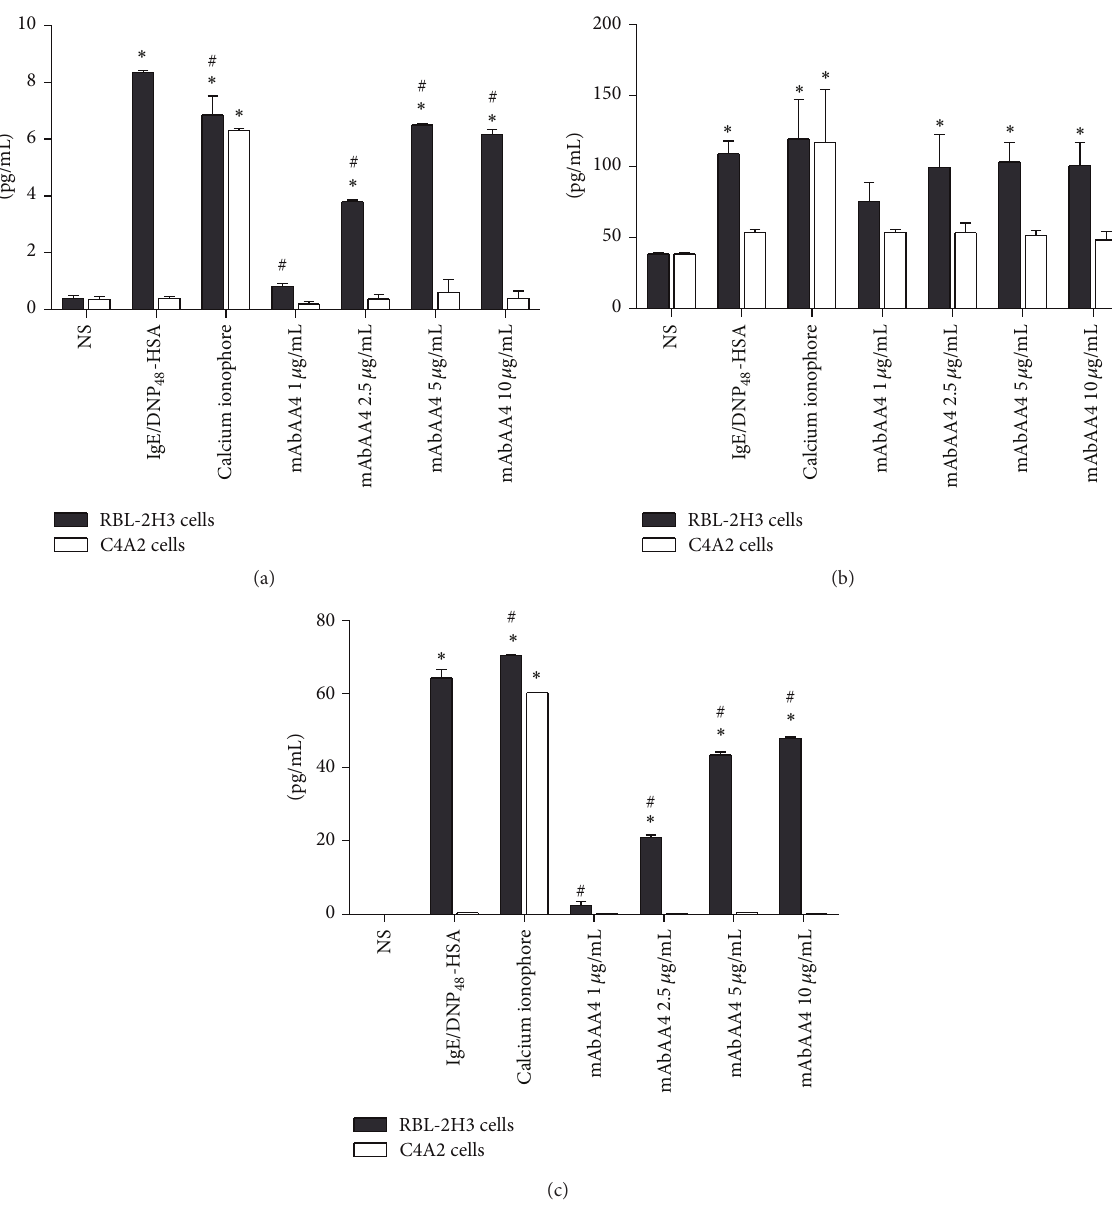
Figure 3: Cross-linking GD1b derived gangliosides with mAbAA4 induced the release of IL-4, IL-6, and TNF- 𝛼 in a Syk-dependent manner. For stimulation via Fc 𝜀 RI, RBL-2H3 cells and C4A2 Syk-negative cells were sensitized with IgE anti-TNP and stimulated with DNP 48 -HSA (50 ng/mL). For Fc 𝜀 RI independent stimulation, the cells were incubated with calcium ionophore (0.1 𝜇 g/mL). To cross-link GD1b derived gangliosides, cells were incubated with mAbAA4 (1, 2.5, 5, and 10 𝜇 g/mL). Nonstimulated (NS) cells were used as negative controls. Culture supernatants were collected 1h after stimulation and the cells were rinsed and cultured for an additional 11h to evaluate cytokine release. IL-4 (a), IL-6 (b), and TNF- 𝛼 (c) were measured in the culture supernatants by ELISA. Data is expressed as the mean ± SD of three independent experiments. ∗ 𝑃 < 0.05 between experimental samples and the nonstimulated (NS) cells. # 𝑃 < 0.05 between experimental samples and Fc 𝜀 RI stimulated RBL-2H3